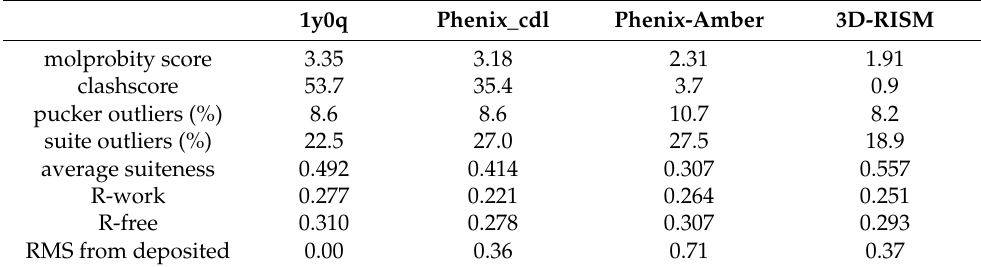
Table 3. Results for several test refinements of 1y0q. The first seven rows come from the molprobity program [30]; the root-mean-square (RMS) change from the deposited structure is computed for all non-hydrogen atoms.